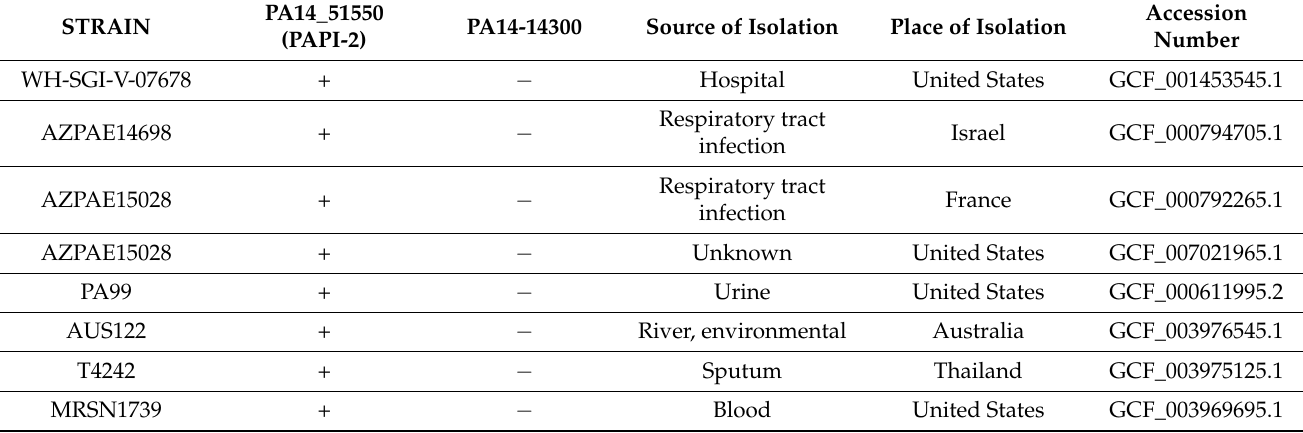
Table 1. Strains encoding both ExoS and ExoU in their genome that are deposited in the PsGenDatab.